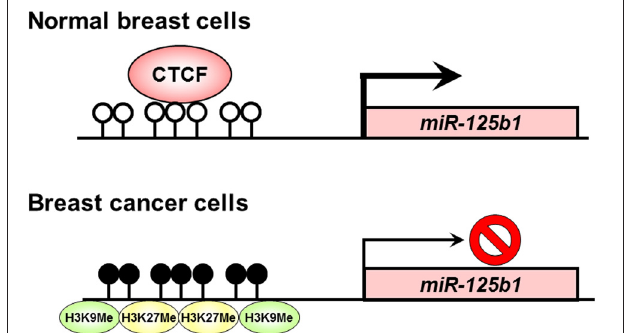
FIGURE 1 | Disruption of CTCF binding at the miR-125b1 CpG island in human cancers. In normal breast cells, CTCF might prevent the recruitment of epigenetic silencing components, such as DNA methylation and repressive histone modifications, and also favors an open chromatin structure. Meanwhile, in breast cancer cells, the loss of CTCF is associated with CpG island methylation and the gain of repressive histone modifications such as histone H3 K9 trimethylation and histone H3 K27 trimethylation. Open circle, unmethylated DNA; filled circle, methylated DNA; H3K9Me, histone H3 K9 methylation; H3K27Me, histone H3 K27